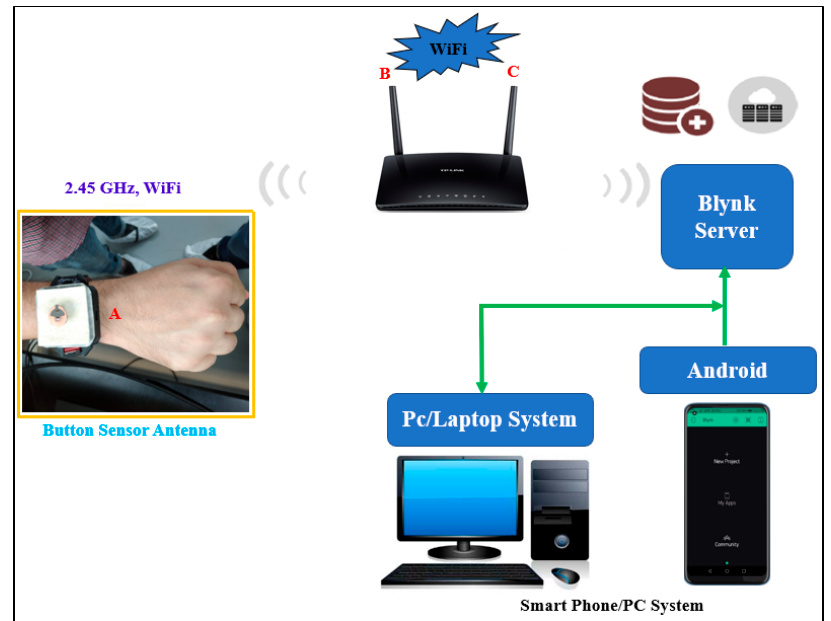
Figure 2. Design system architecture for the button sensor antenna (Point A: BSA Device, and Points B, C: WiFi Router) .